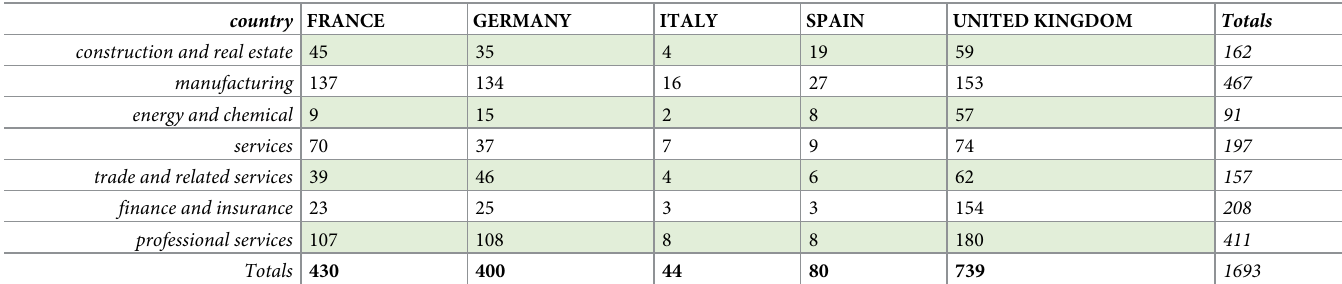
Table 2. Number of companies by industry and